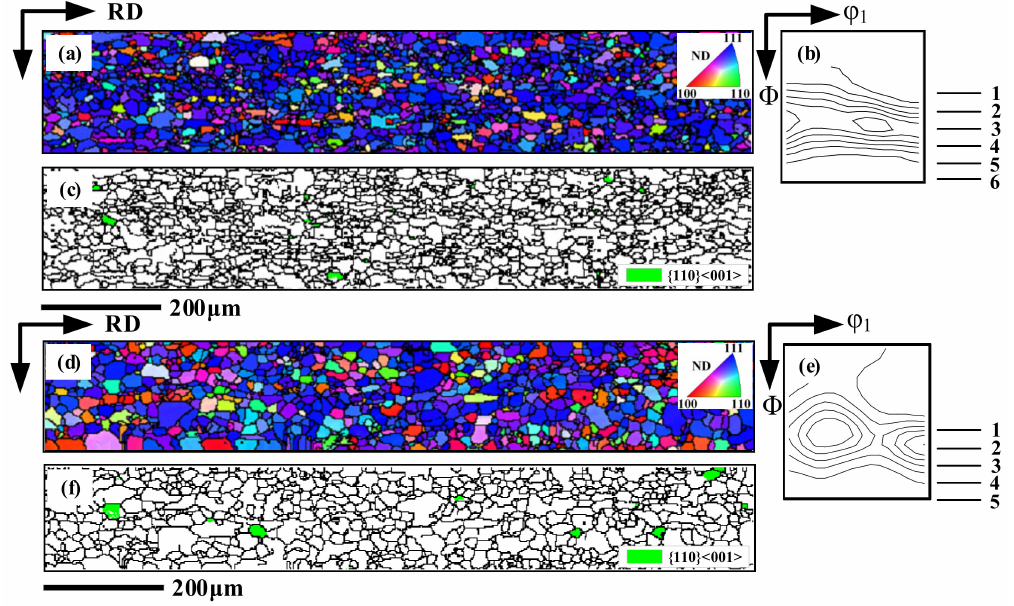
Figure 6. EBSD orientation image maps of primary annealing sheets ( a , d ) and Goss texture with the deviation of 15 ◦ ( c , f ), as well as corresponding ϕ 2 = 45 ◦ ODF sections ( b , e ) of conventional ( a – c ) and twin-roll casting ( d – f )